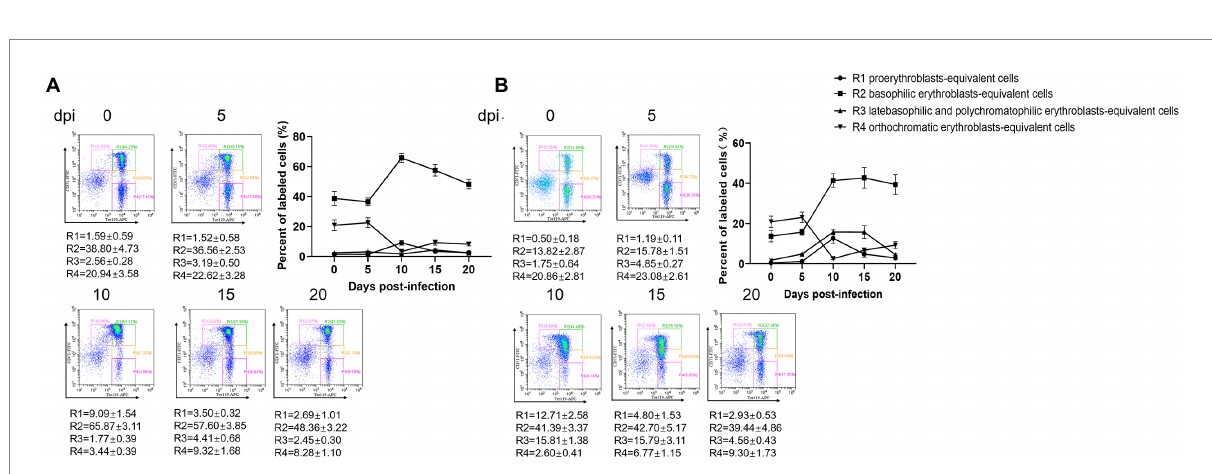
FIGURE 4 Erythropoiesis of red blood cells after infection with B. microti . Line graph showing the arithmetic means ± SD of the percentage of Ter119-PE and CD71-FITC labeled bone marrow (A) and splenocytes (B) isolated from mice in the B. microti -infected